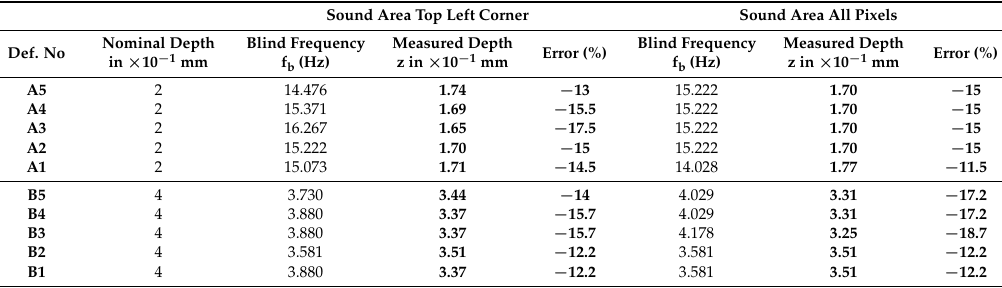
Table A2. Depth estimation using blind